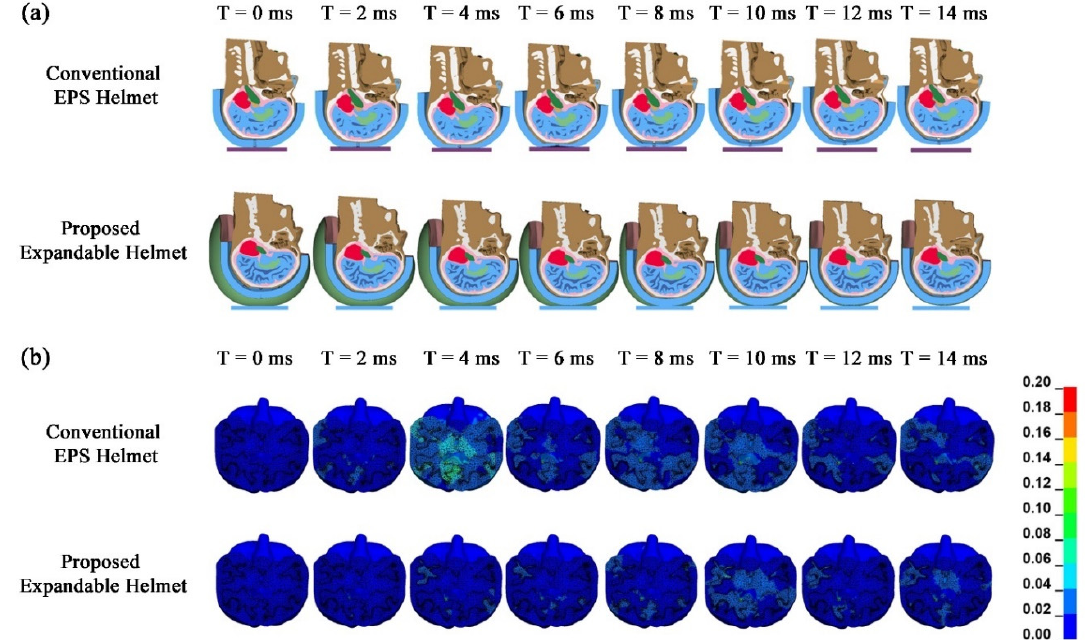
Figure 4. Comparison of the EPS-only helmet and the expandable-airbag EPS helmet. ( a ) Transient response and ( b ) maximum principal strain (MPS).